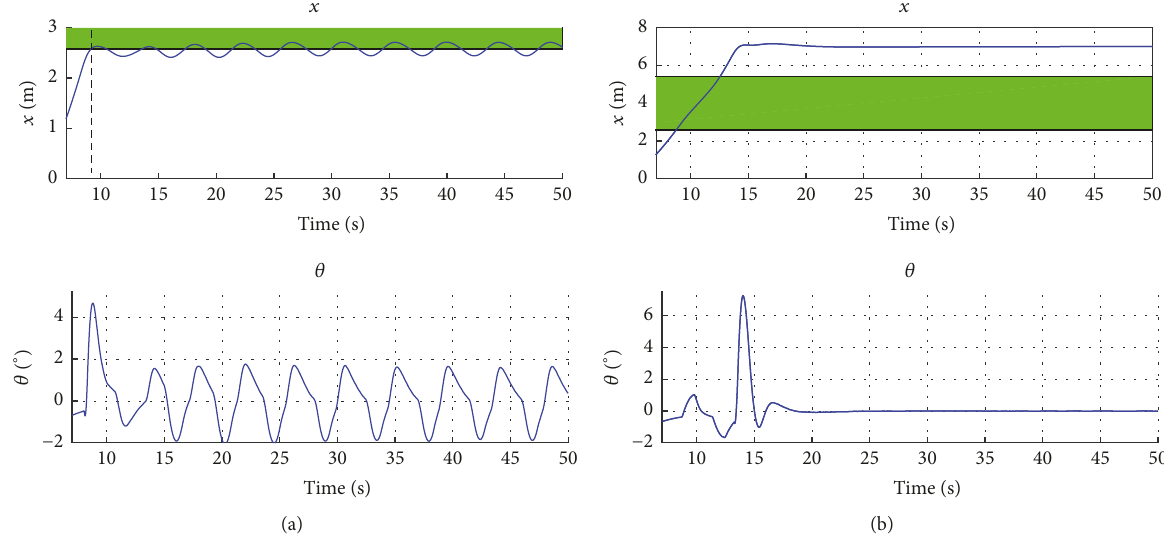
Figure 14: PID controller: velocity of 1m/s and 𝑧/𝑅 = 2 . (a) Hovering in partial ground effect. (b) Flying over obstacle.